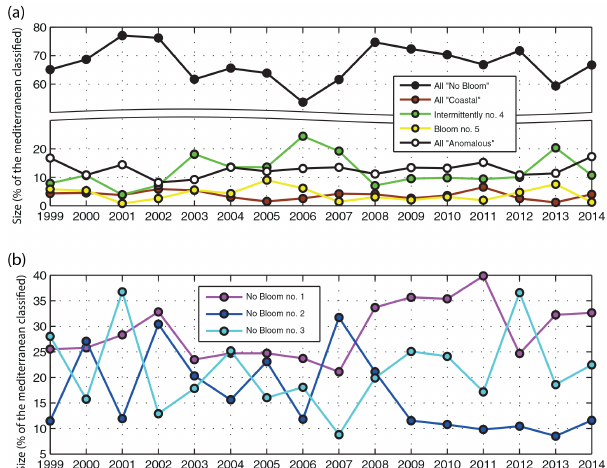
Figure 4. (a) Time series of the area cover by the different biore- gions each year (in % of the Mediterranean classified). All “No Bloom” bioregions are regrouped together, as well as all “Coastal” and all “Anomalous” bioregions. (b) Same as Fig. 4a but only for the three “No Bloom”